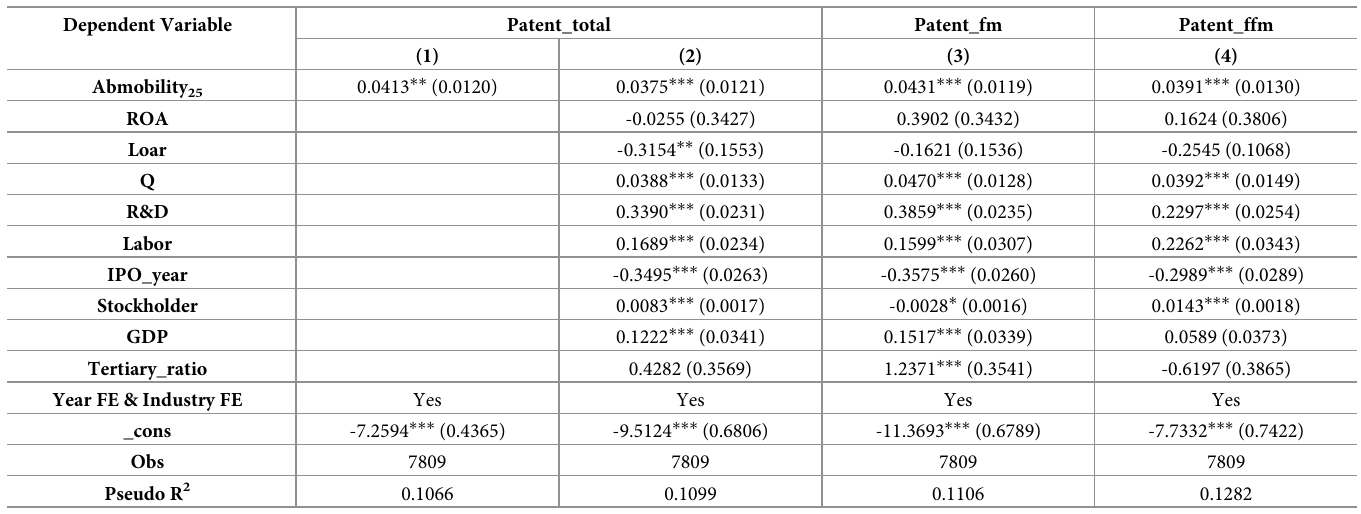
Table 2. Results of baseline